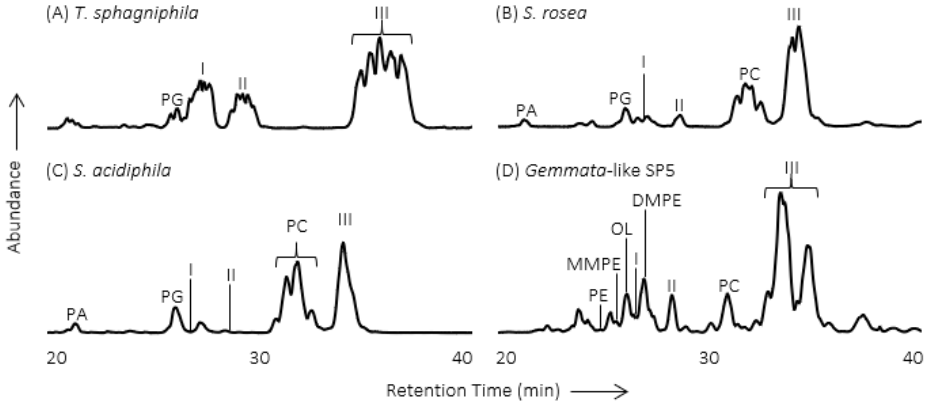
Figure 2. High-performance liquid chromatography-mass spectrometry (HPLC-MS) chromatograms ( m / z 400 to 2000) of Bligh and Dyer lipid extracts from Planctomycete cultures. ( A ) T. sphagniphila; ( B ) S. rosea; ( C ) S. acidiphila; ( D ) Gemmata-like strain SP5. PG = phosphatidylglycerol; PA = phosphatidic acid; PC = phosphatidylcholine; PE = phosphatidylethanolamine; MMPE = monomethyl-phosphatidylethanolamine; DMPE = dimethyl-phosphatidylethanolamine; OL = ornithine lipid; I = monomethylornithine; II = dimethylornithine; III = trimethylornithine. Figure adapted from [16].